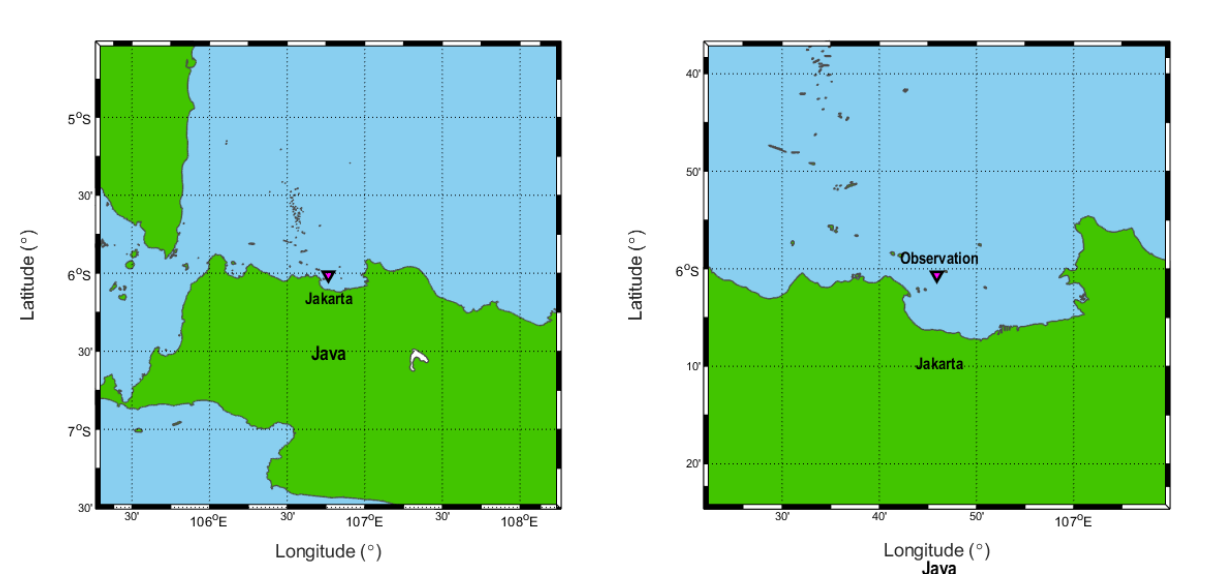
Figure 10. Location of wave observation at Jakarta